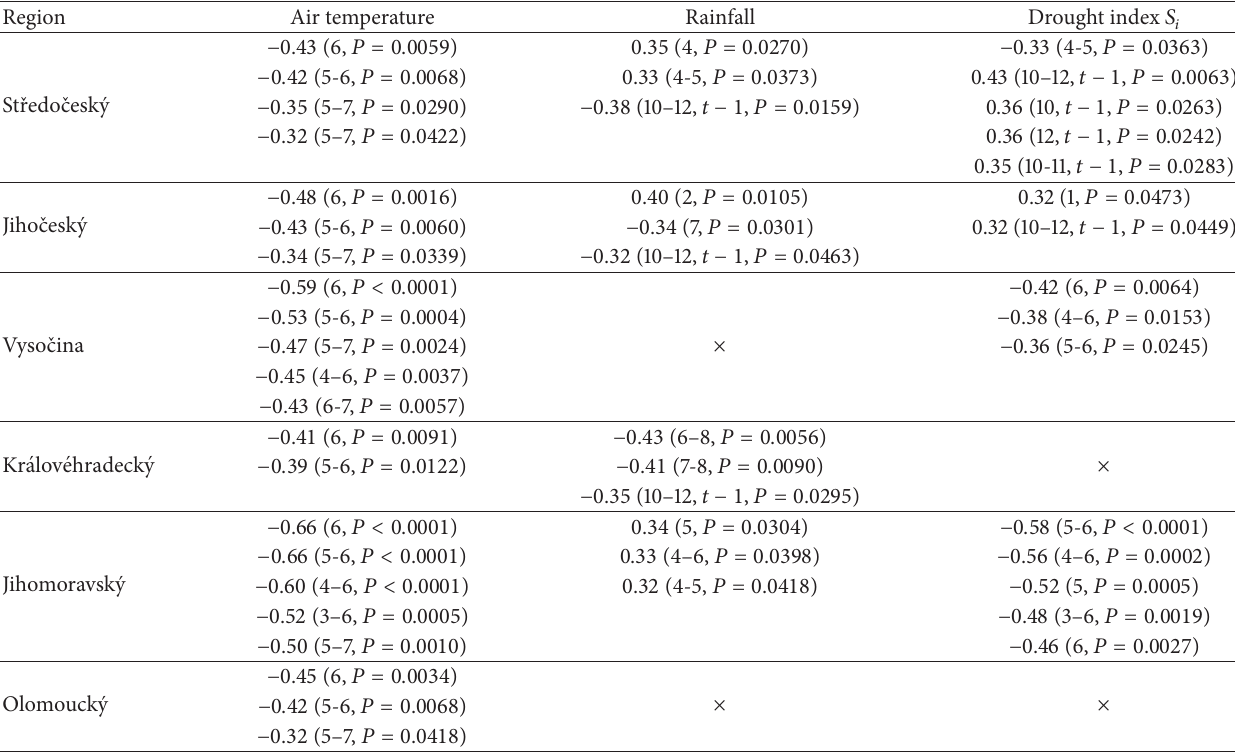
Table 6: The most significant correlation coefficients between wheat yield per hectare and the average characteristics of weather in regions of the CR